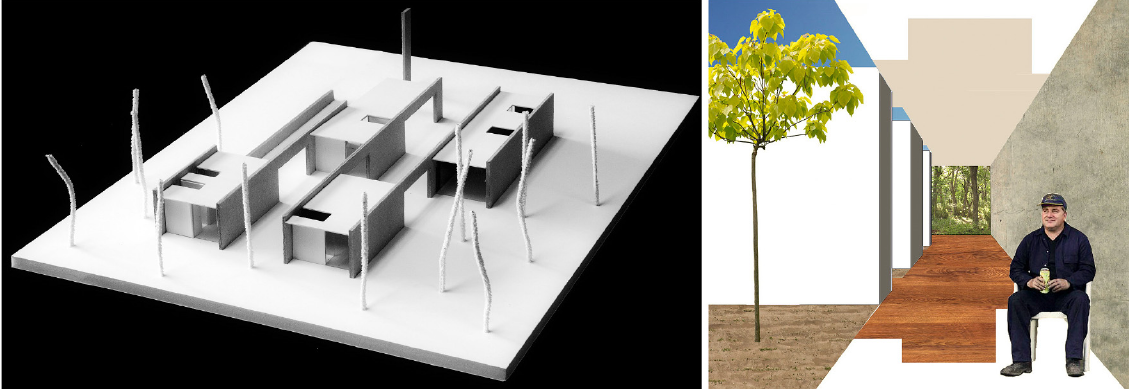
Figure 3. A space for Josie. Student: Jorge Ruberte